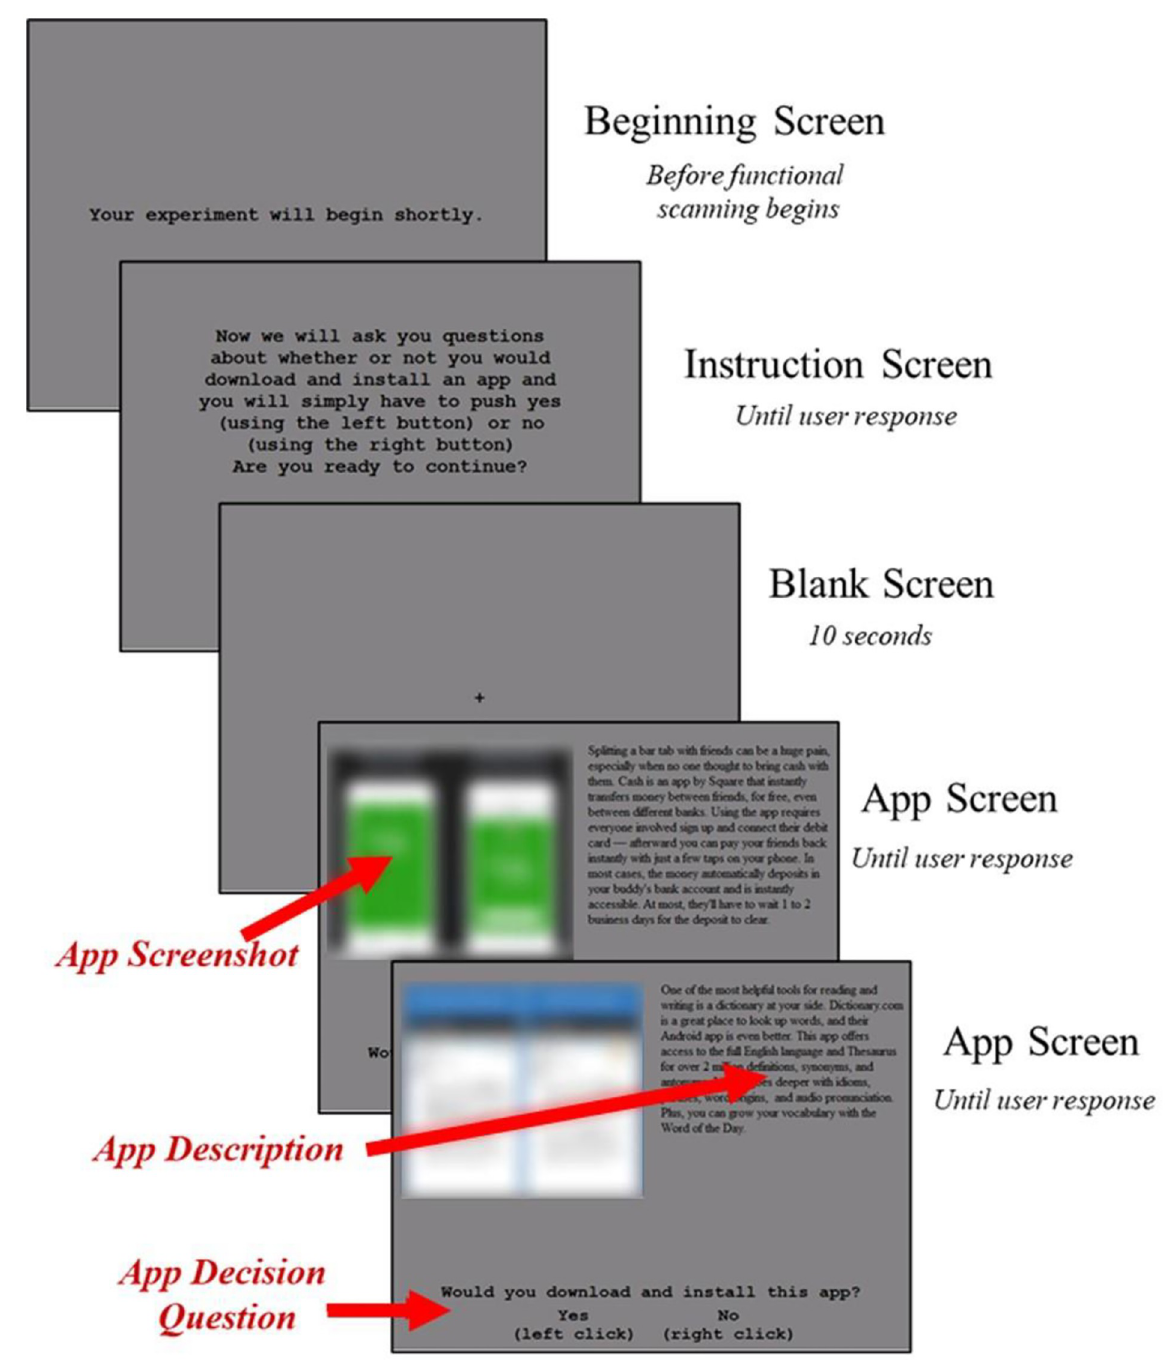
Fig 1. Example stimuli